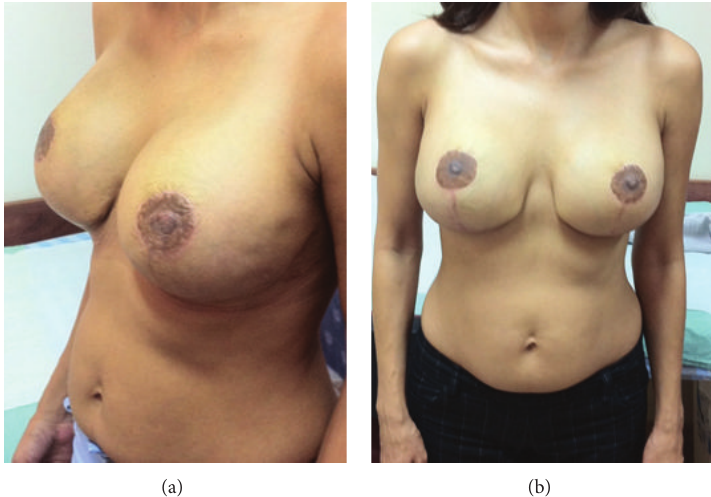
Figure 3: Postoperative result 6 months after the